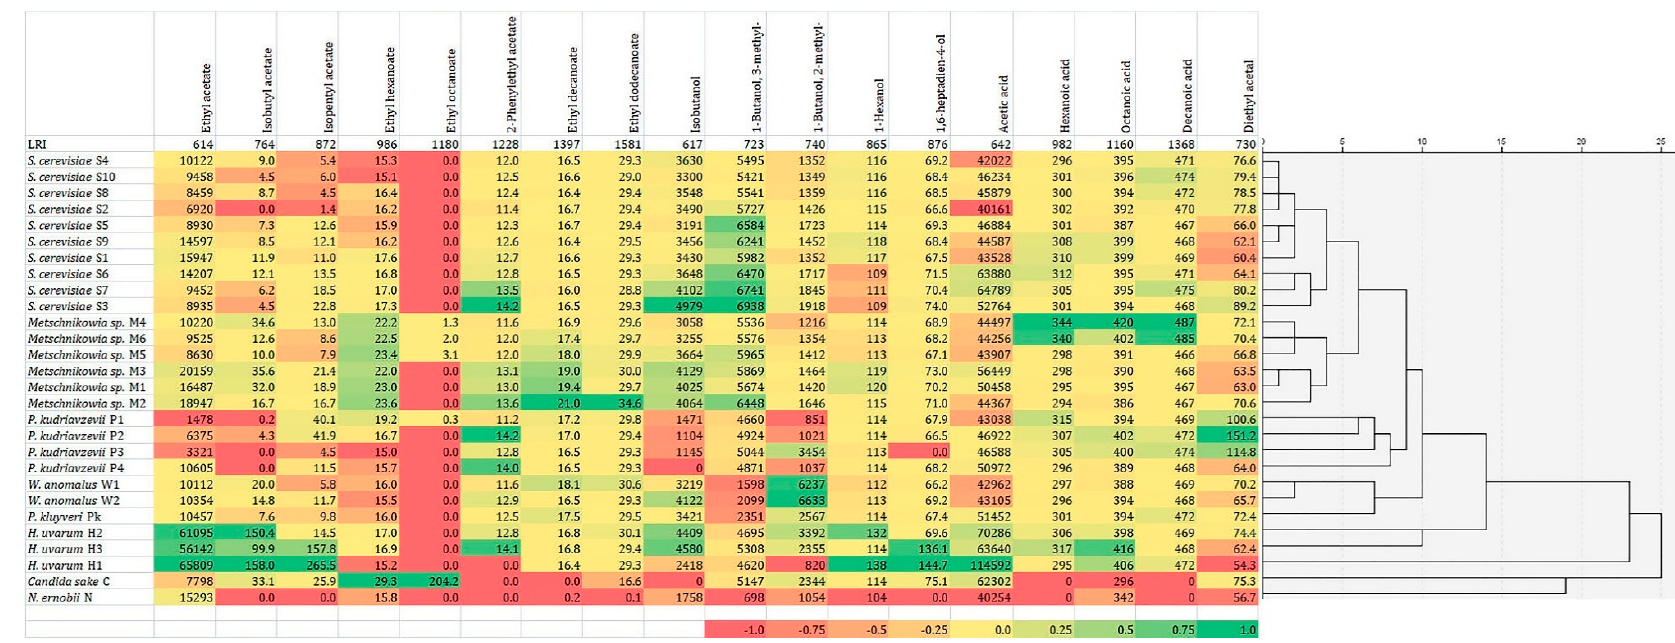
Figure 6. A heat map and cluster analysis results of 18 volatile components [ µ g L − 1 ] produced by yeast strains isolated from various fermenting plum mashes of analyzed varieties (LRI—linear retention